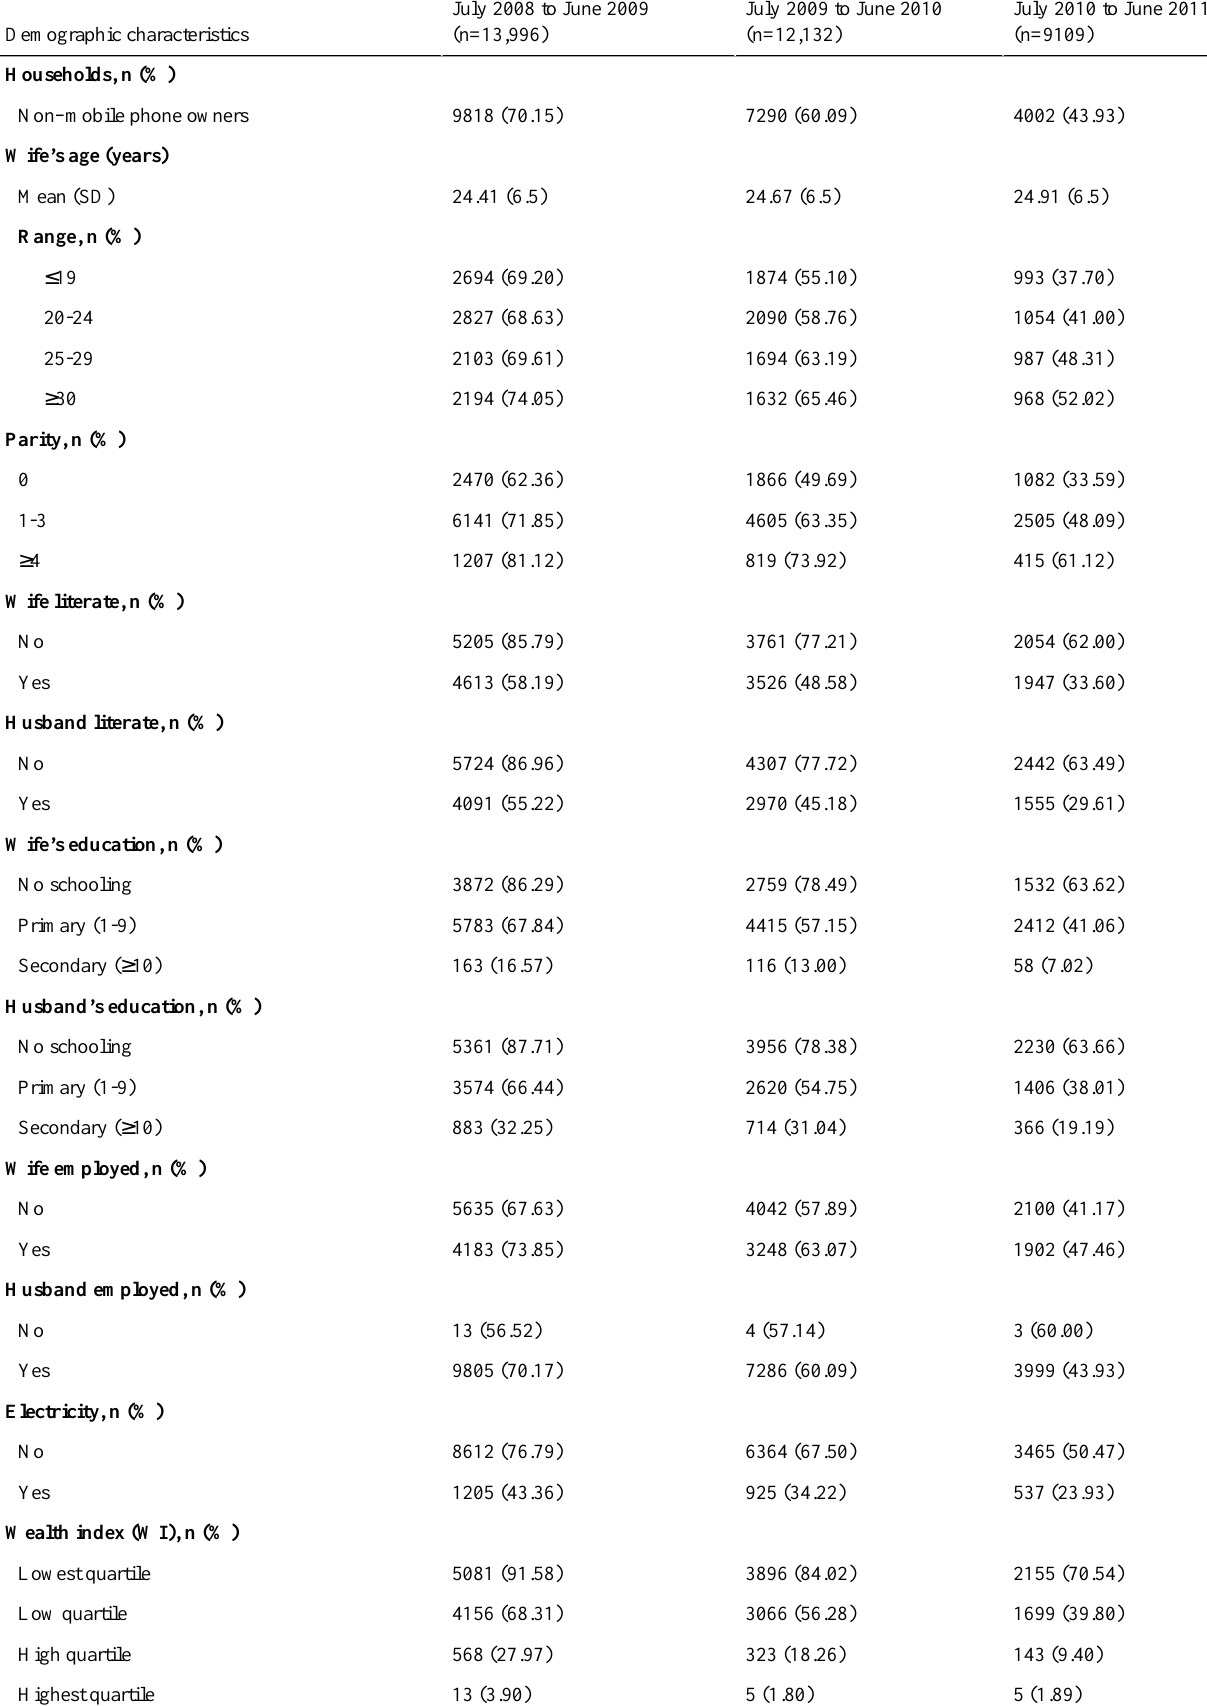
Table 2. Demographic characteristics of mobile phone nonowners by fiscal year,